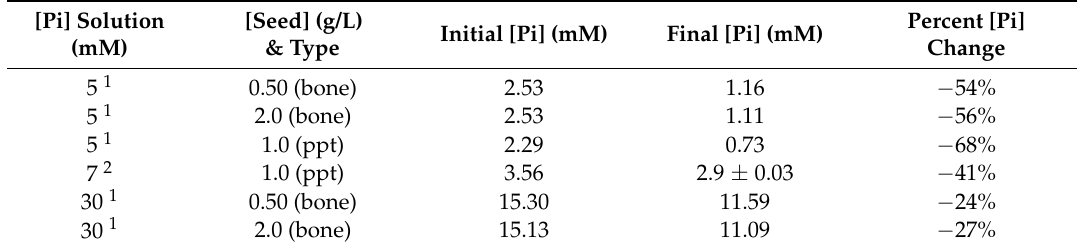
Table 6. Summary of [Pi] results for the batch, seeded precipitation tests.